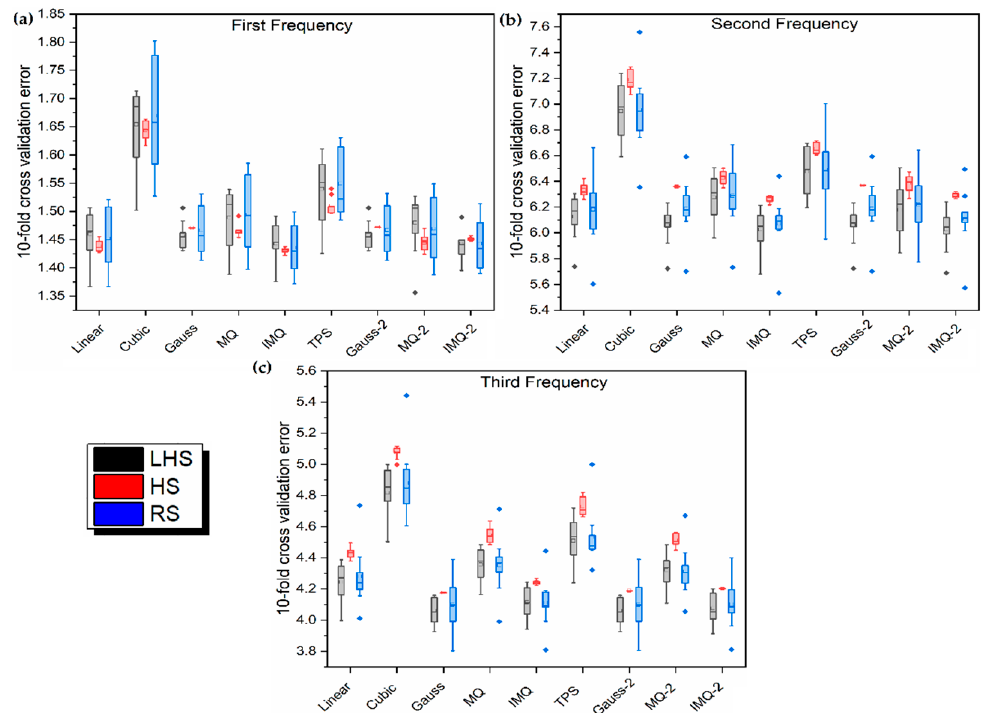
Figure 9. 10-fold cross-validation error of various RBF metamodels in HD-problem.